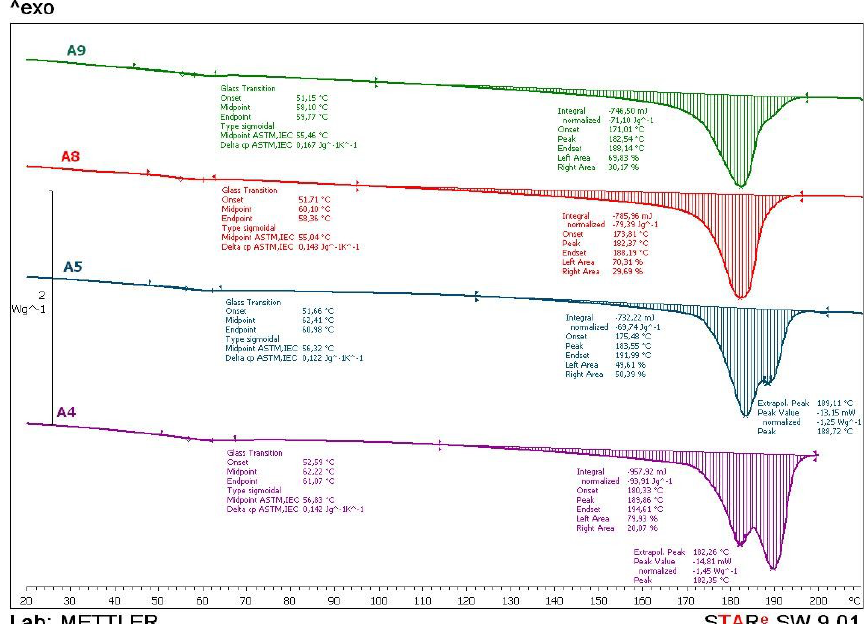
Figure 14. Comparative DSC thermograms of A4, A5, A8 and A9 samples obtained during the first heating cycle.